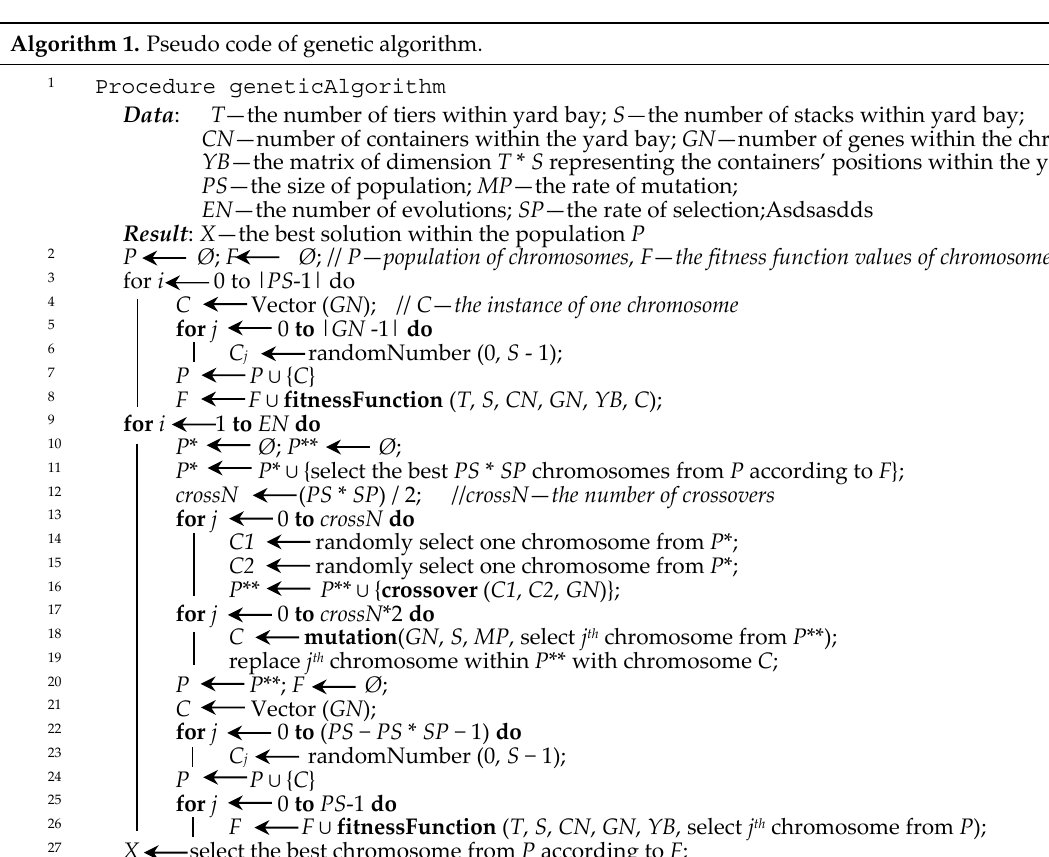
Figure 3. The example of CRP with yard bay with 4 tiers and 4